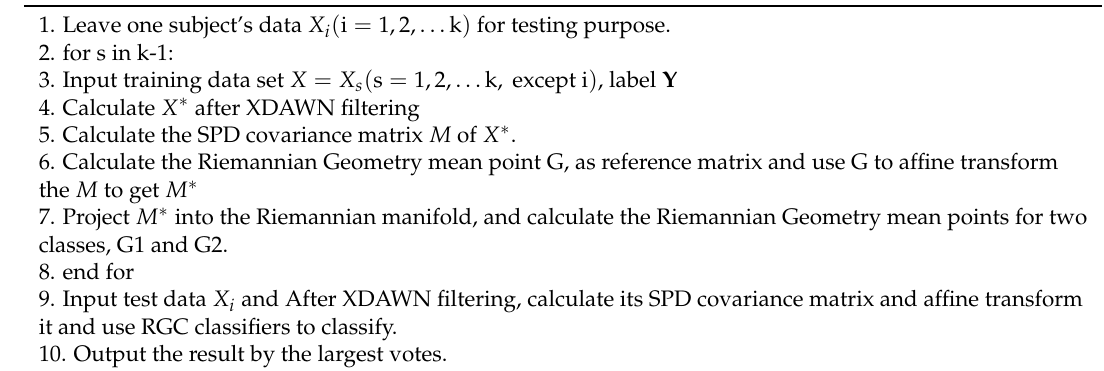
Table 2. Algorithm of experiment